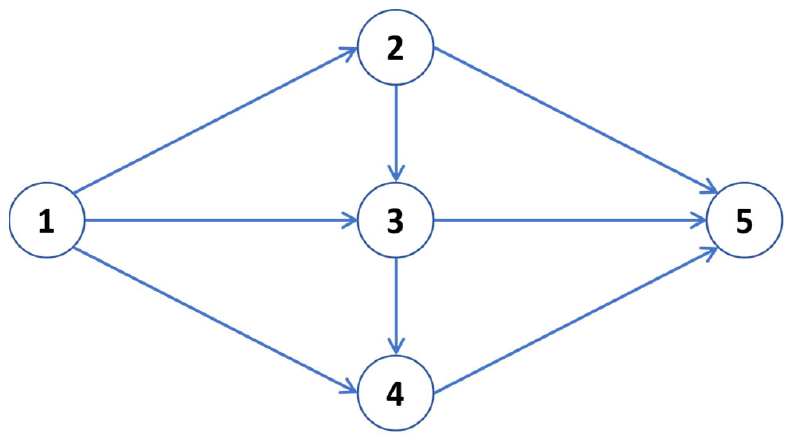
Figure 6. Precedence diagram of project tasks displayed by the AOA system.